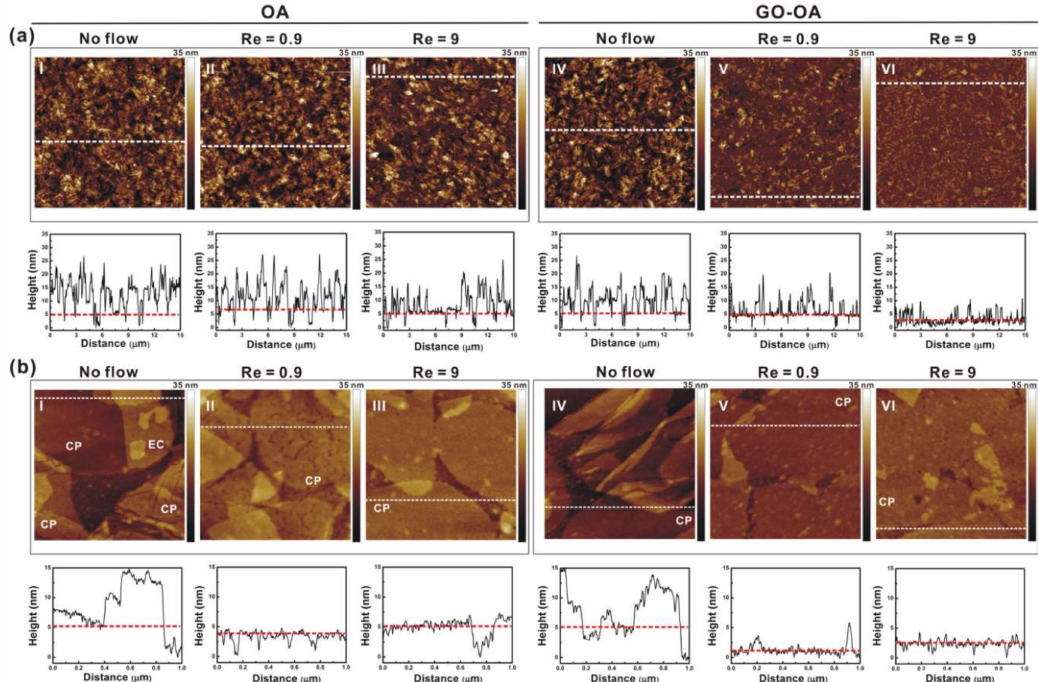
Figure 3. (Upper) AFM topographic images and (lower) sectional profiles of b-PM layers fabricated on (I–III) pure OA-coated and (IV–VI) GO-OA complex liker-coated mica. b-PM coated mica was subjected to AFM analysis (I,IV) without and (II,III,V,VI) with post-deposition washing with a (II,V) low and (III,VI) high microfluidic shear flow. Scan size: ( a ) 15 µ m and ( b ) 1 µ m. Sectional profiles were analyzed along the white dotted lines on the images, with the bottommost b-PM monolayers indicated by red dotted lines. EC and CP denote the exposed side of each b-PM